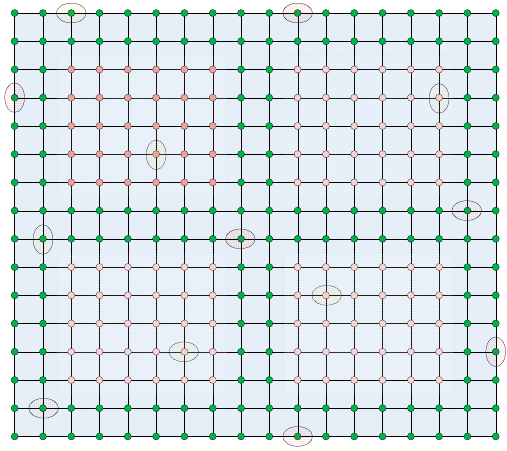
Figure 3. Topological map of the storage area.